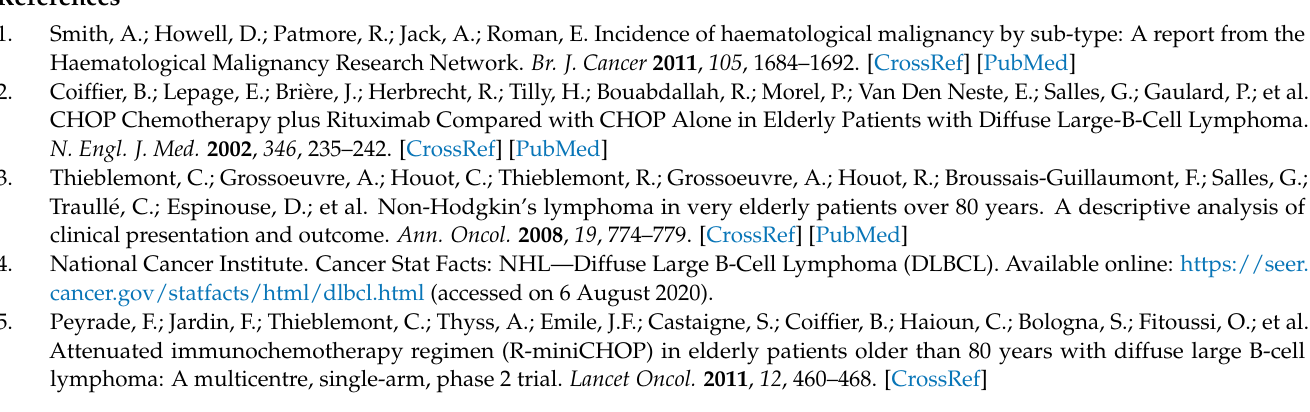
Supplementary Figure S2: Isobologram analysis of OCI-LY3 cell growth inhibition by the concomitant combination of metronomic vinorelbine (VNR) and etoposide (ETO); Supplementary Table S1: Causes of death of 15 patients treated with